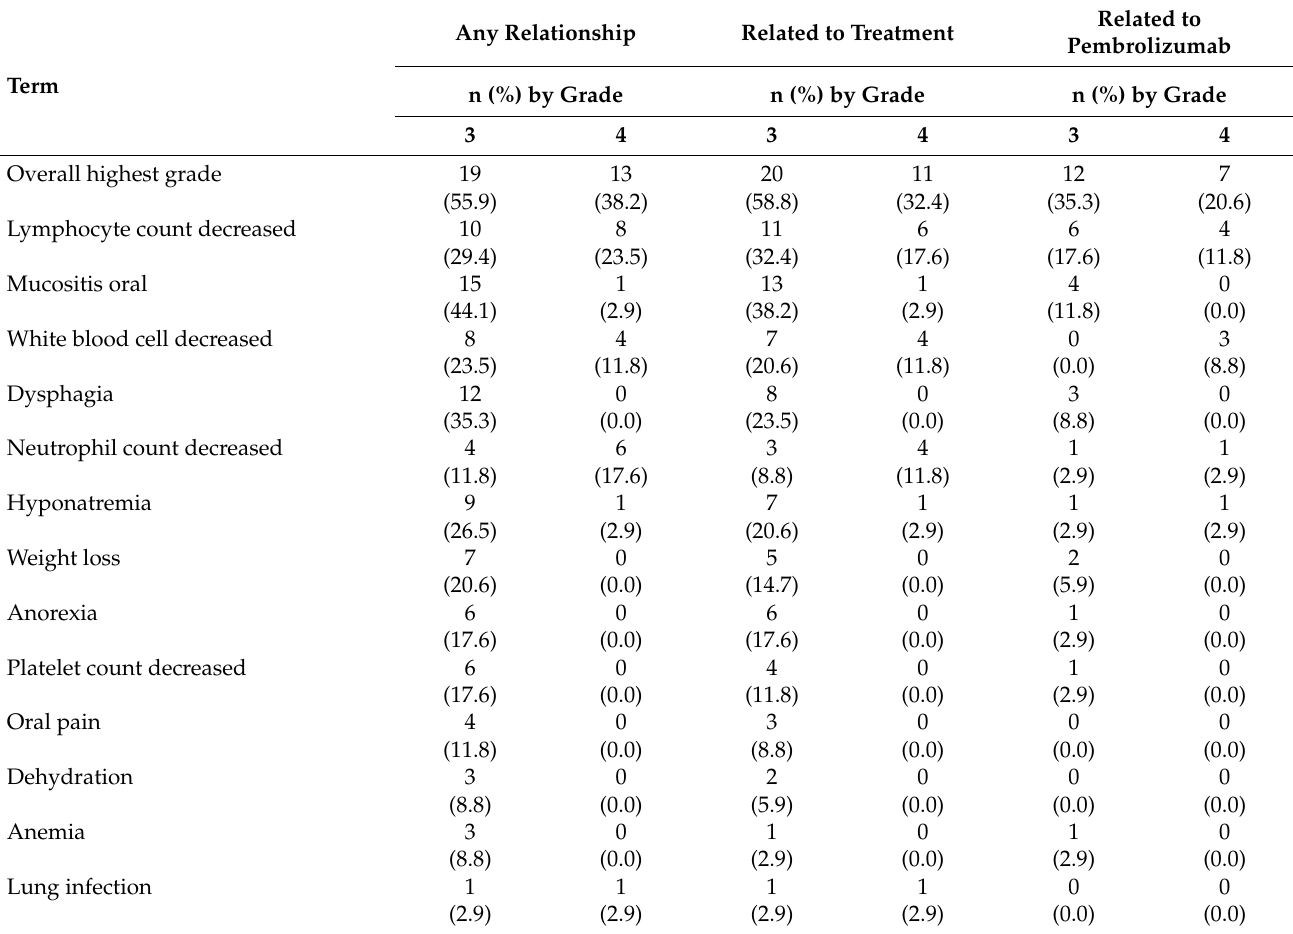
Table 3. Summary of Grade 3–4 Acute Adverse Events for Analyzable Patients in NRG-HN003 (n =